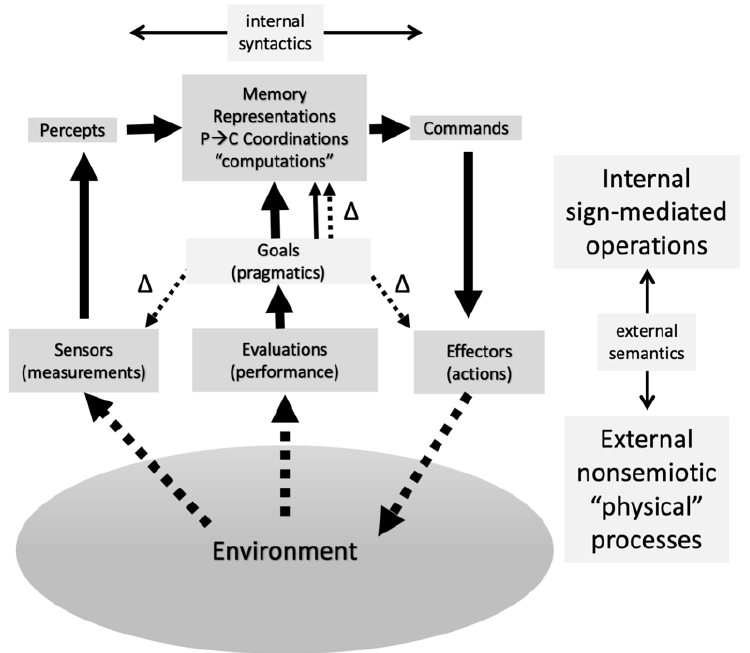
Figure 1. Functional organization of a generic purposive, cybernetic percept-coordination-action system. Solid lines indicate sign-mediated processes, whereas dashed lines indicate non-semiotic physical processes. See [22–24,59] for more detailed explanations.